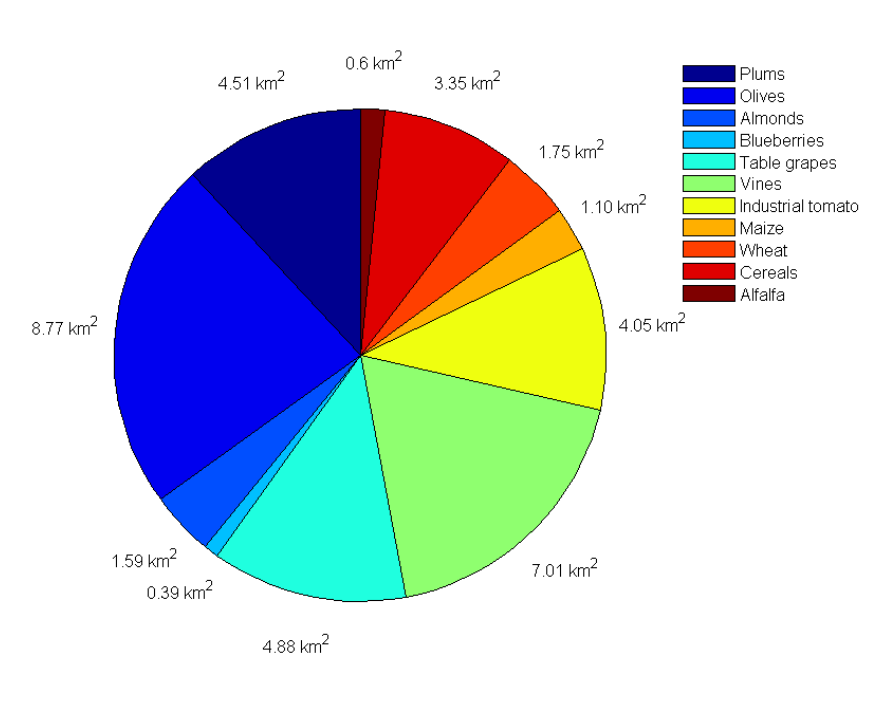
Figure 2. The main agricultural land-use types.